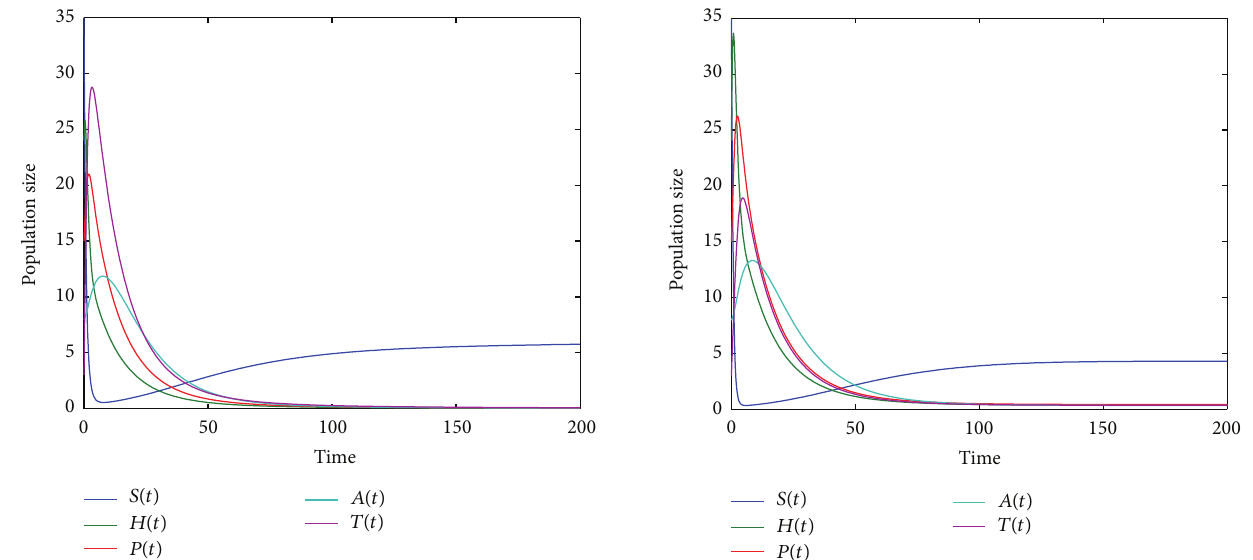
Figure 4: When 𝑘 3 = 0.05 , 𝑘 4 = 0.4 , and 𝑅 0 = 1.412 > 1 , the endemic equilibrium is globally asymptotically stable.